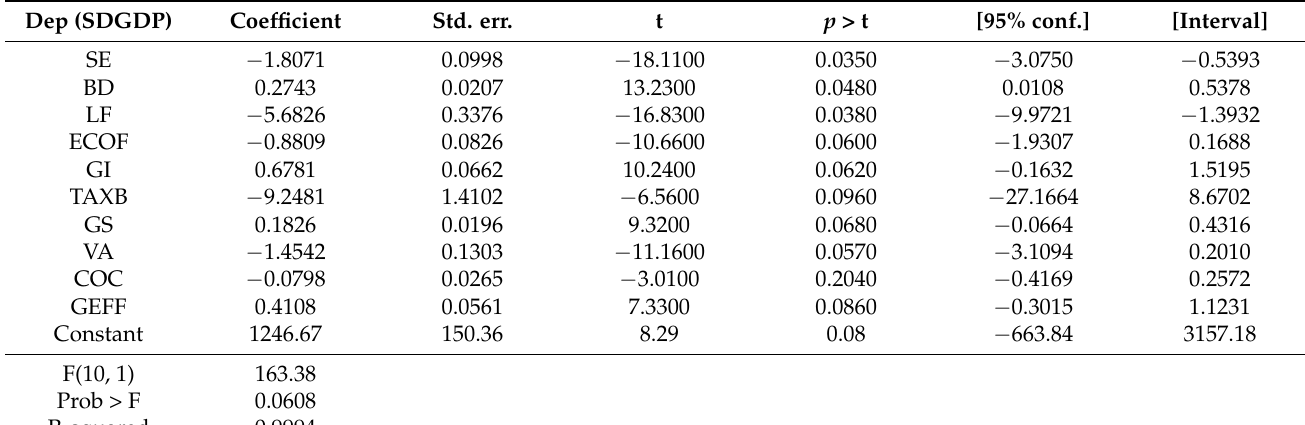
Table 4. Impact of shadow economy on economic stability in the case of Saudi Arabia. Dep